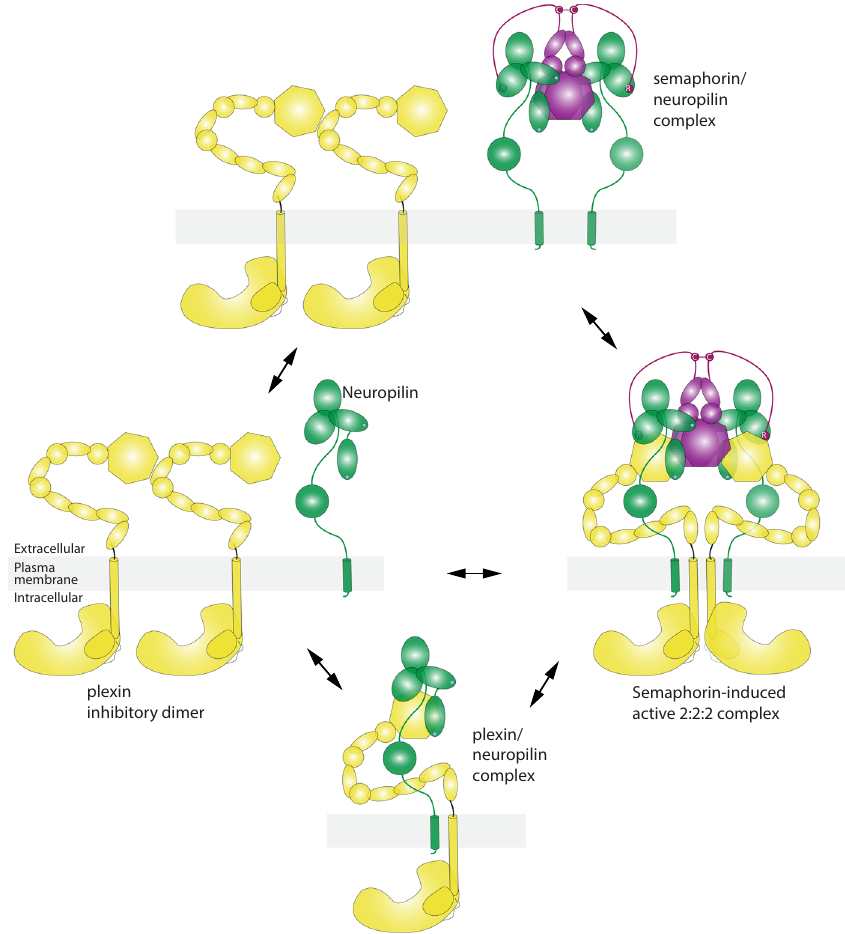
Fig. 6 Cartoon model of the regulatory mechanisms of class A plexins. Prior to ligand binding, class A plexins form the inhibitory dimer that prevents the formation of the intracellular active dimer (left panel). It is possible that neuropilin uses its a1 domain to bind plexin, disrupting the inhibitory dimer and priming plexin for activation (lower panel). Neuropilin could bind the semaphorin dimer on its own, considering the strong interaction between the two (upper panel). Ultimately, the semaphorin dimer induces the formation of the 2:2:2 complex, which in turn induces the intracellular active dimer of plexin for signaling (right panel). Whether and how the transmembrane region of plexin and neuropilin interact in the 2:2:2 complex is